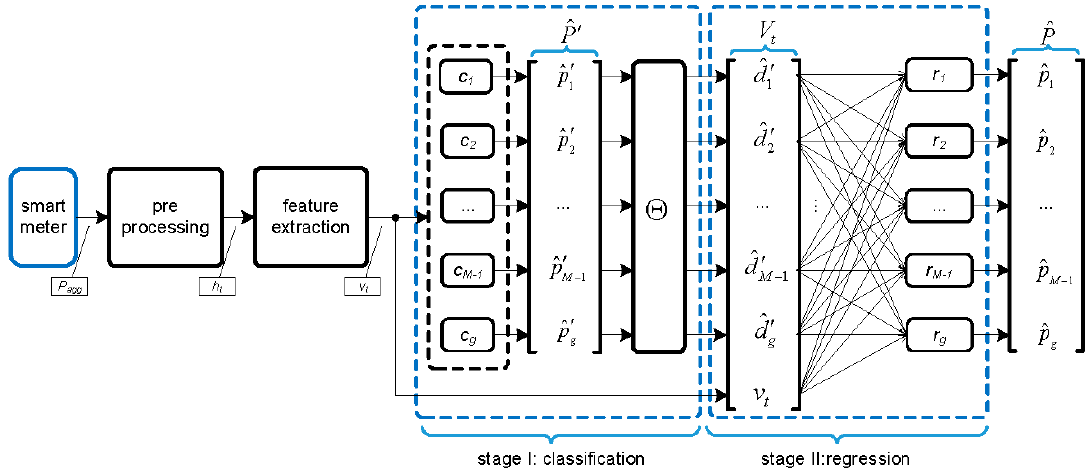
Figure 2. Block diagram of the proposed two-stage energy disaggregation methodology.